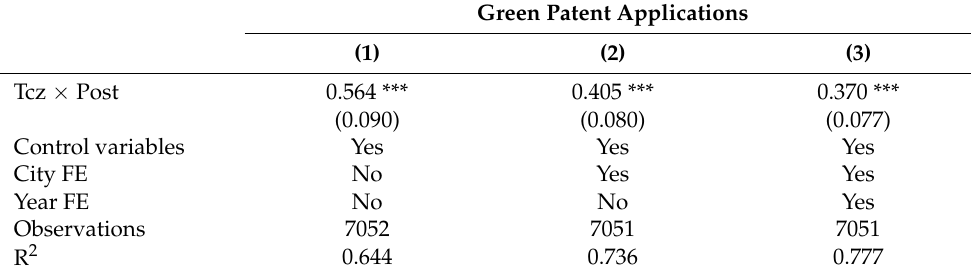
Table 3. PSM–DID